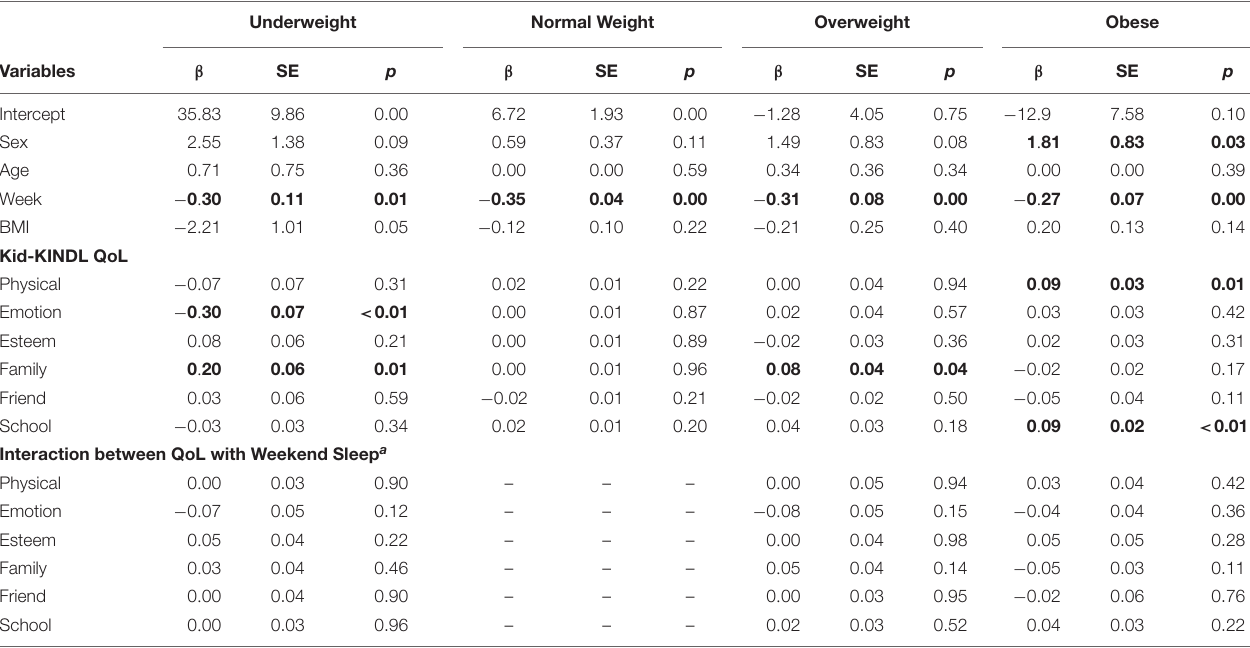
TABLE 2 | Health-related quality of life indicators of children’s sleep duration across different BMI ranges. Underweight Normal Weight Overweight